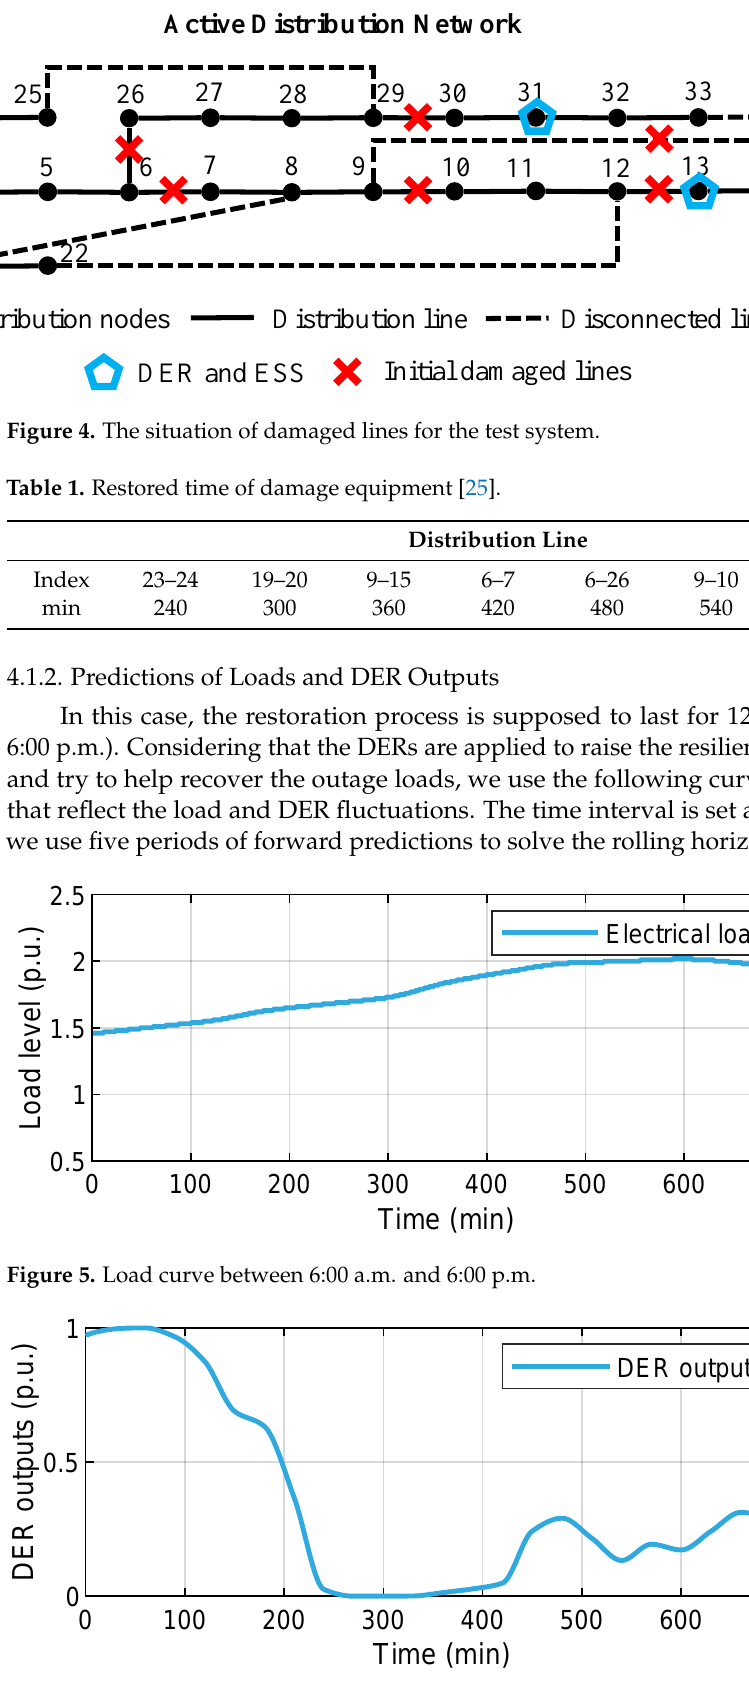
Figure 6. DER outputs curve between 6:00 a.m. and 6:00